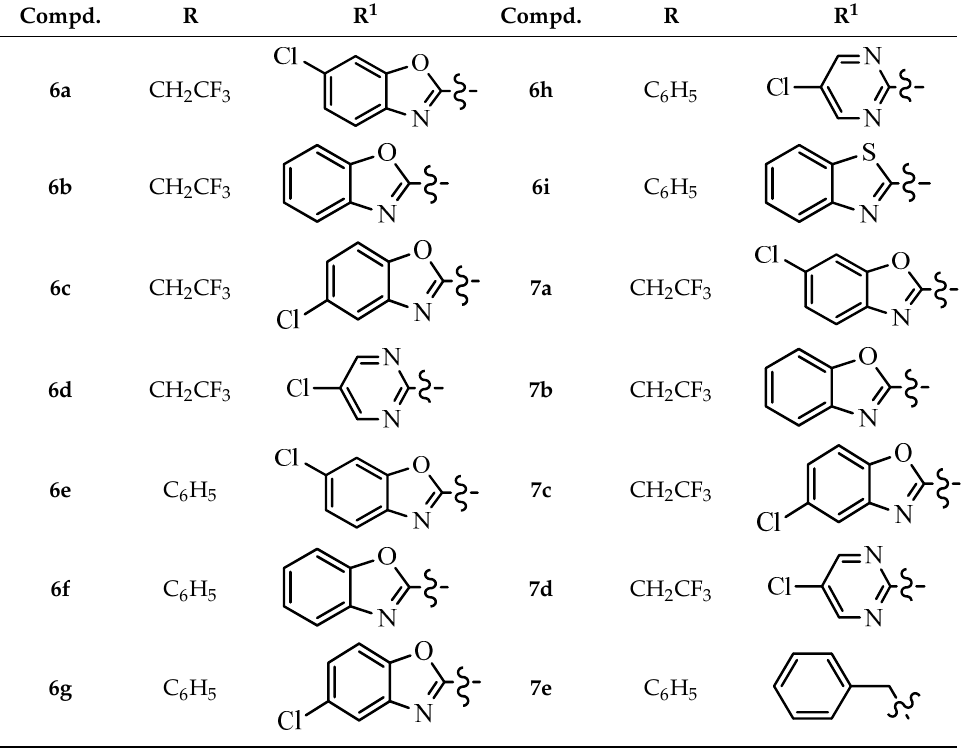
Table 1. Chemical structure of target compounds Compd. R 1